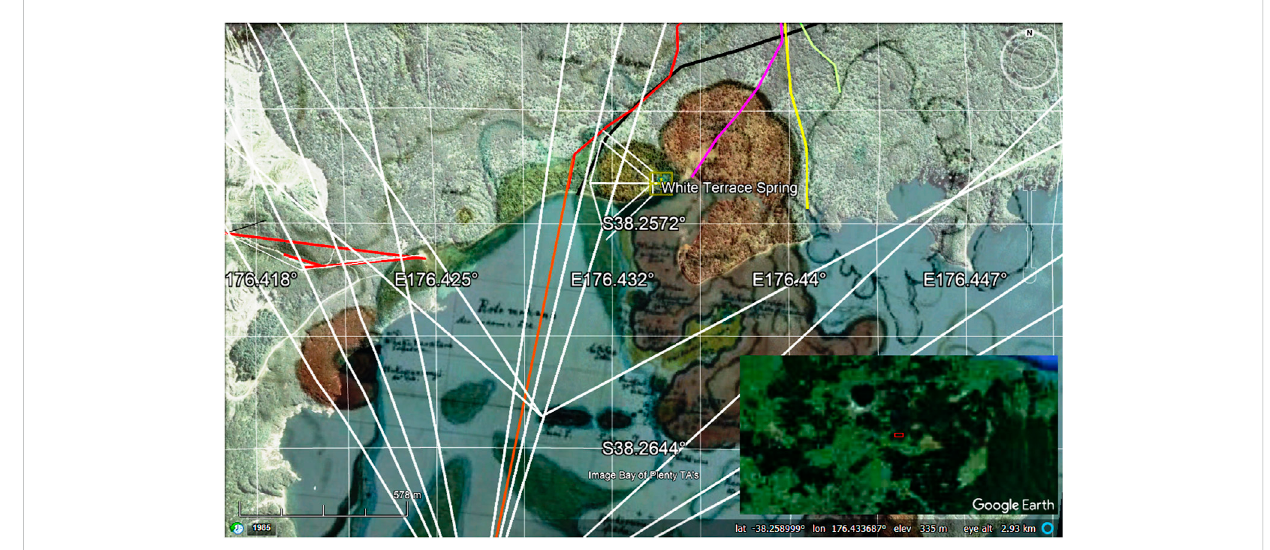
FIGURE 9 GeoreferencedSteaming Ranges (in umber), overtheTarata Peninsula onGoogleEarth ™ , withLake Rotomahana andWhiteTerraceon theleftand LakeRotomakaririontheright.Theriverentrypathsareshownanddiscussed.TheoverviewmapmarksthelocationinthenorthernTaup ō VolcanicZone (Hochstetter ’ s 30 April 1859 map). Refer to Figure 1 for location